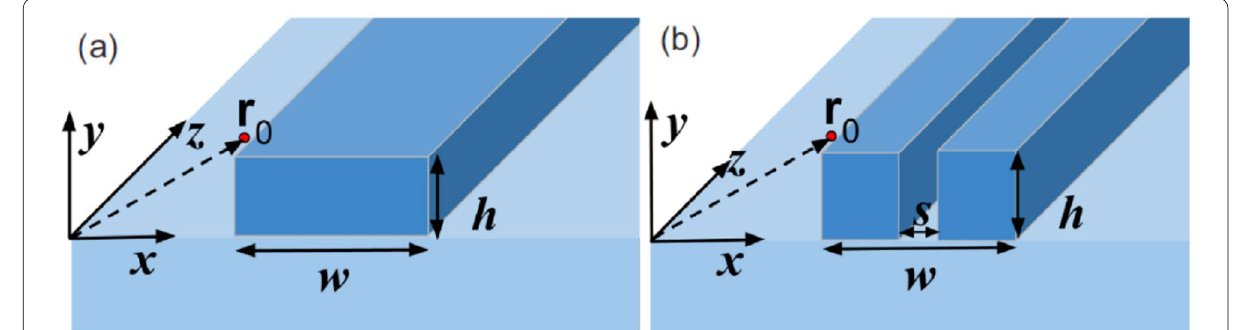
Fig. 2 Schematic of a dielectric a strip and b slot waveguides defined by a core of higher refractive index (Si 3 N 4 , TiO 2 or silicon) patterned on a lower index bottom cladding (typically silicon dioxide). The scattering particles are assumed to be embedded with a uniform density in the upper cladding (colorless region). A particle at position r 0 is shown for both cases. (Reprinted with permission from Ref.